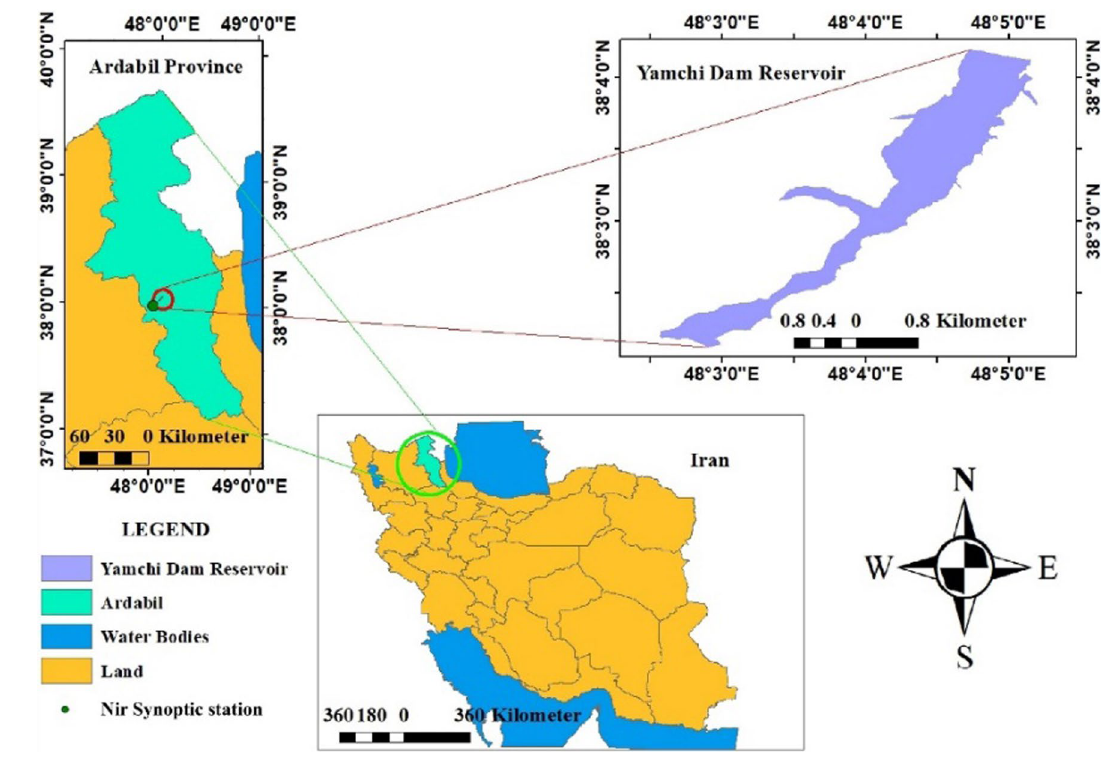
Fig. 1 Location of Yamchi dam